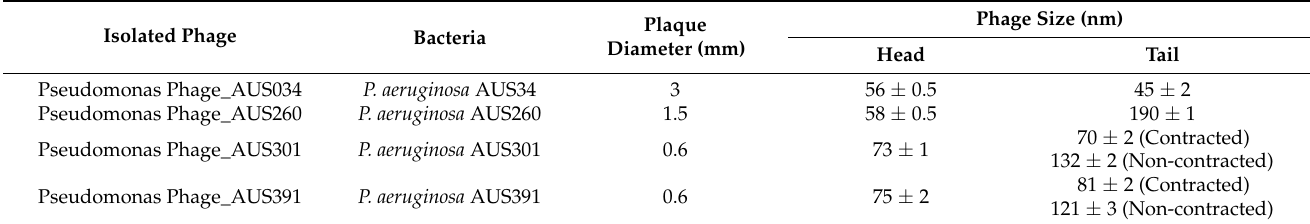
Table 4. Phages isolated using the clinical bacterial strains.